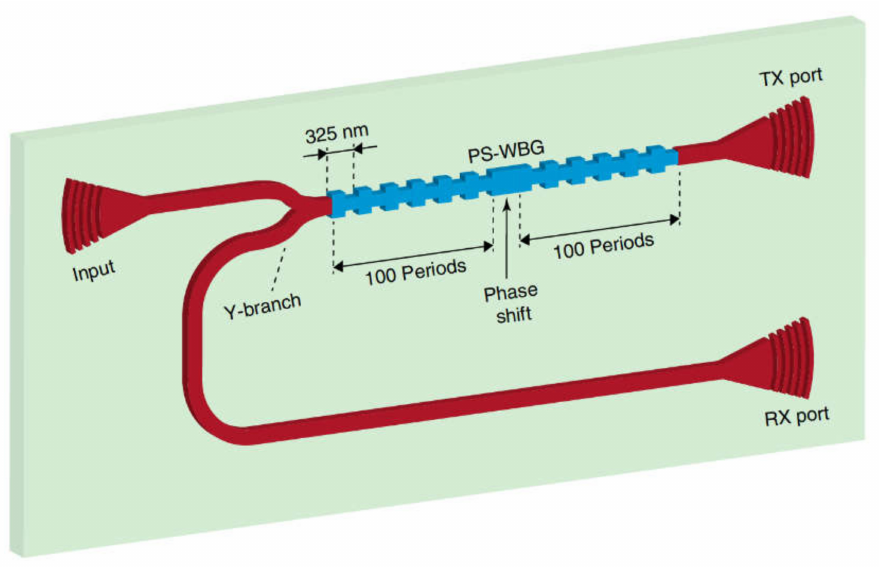
Figure 13. Schematic of a silicon WBG (PS-WBG) employed as a linear optic frequency discriminator. TX port, transmission port; RX port, reflection port [29].